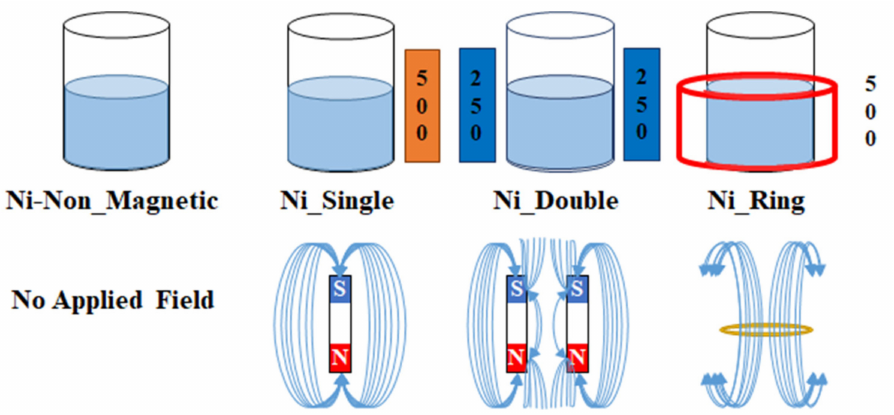
Figure 1. Schematic showing arrangement of magnets to create magnetic field with different shapes, with a magnetic field of 500 Gauss. Below the strength of the magnetic field exposed to the solution, due to the shape of the magnet, is